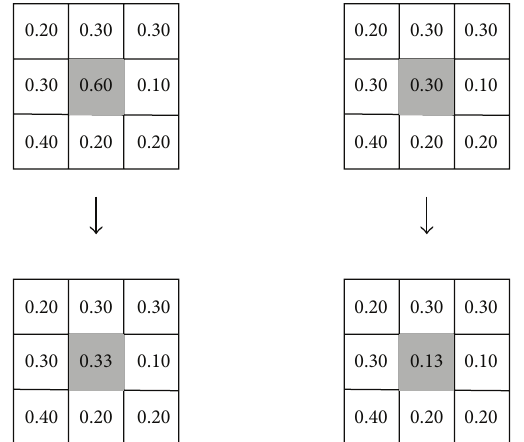
Figure2:Anillustrationtodemonstratetheeffectofremovingnoise by exploiting spatial information. The left and right columns show the variation of the membership functions of a noisy pixel and a noise-free pixel, respectively.